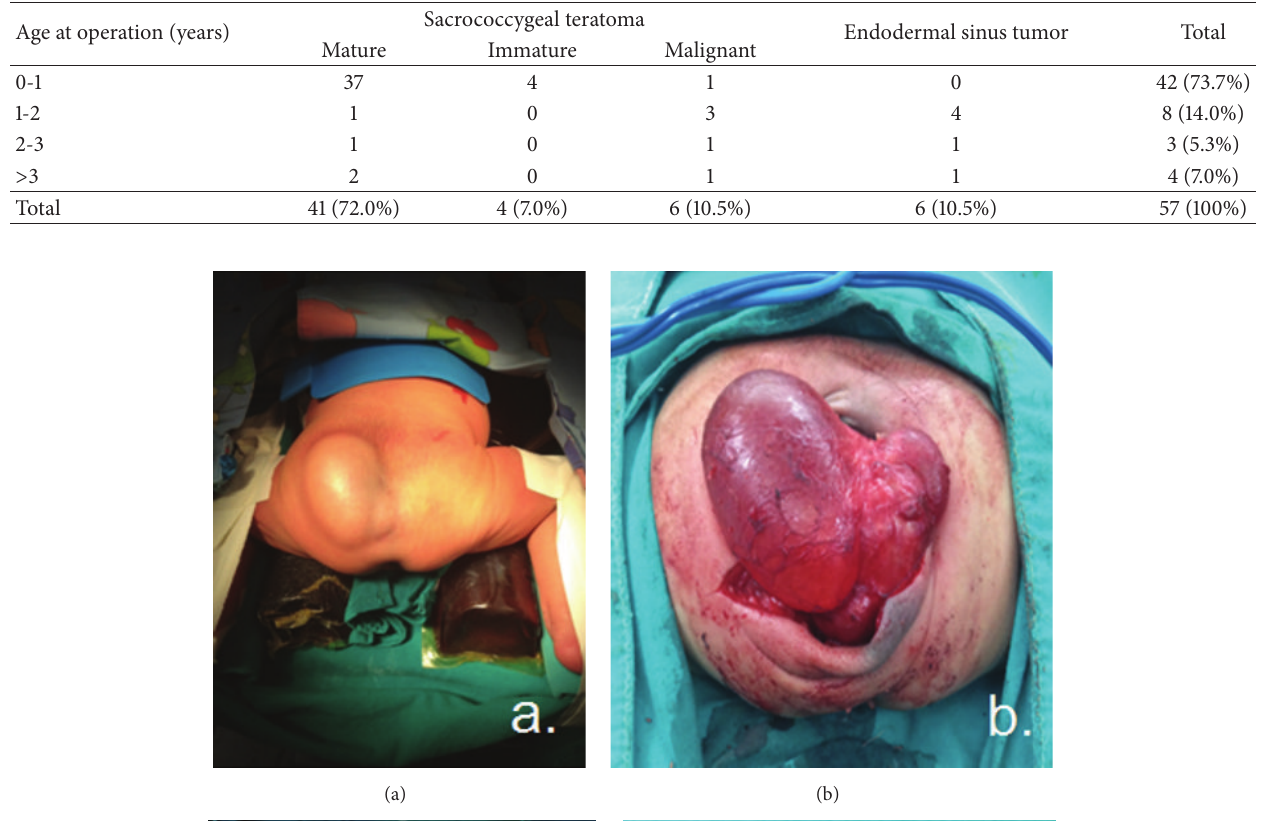
Table 3: Age distribution and histologic types of sacrococcygeal germ cell tumors.